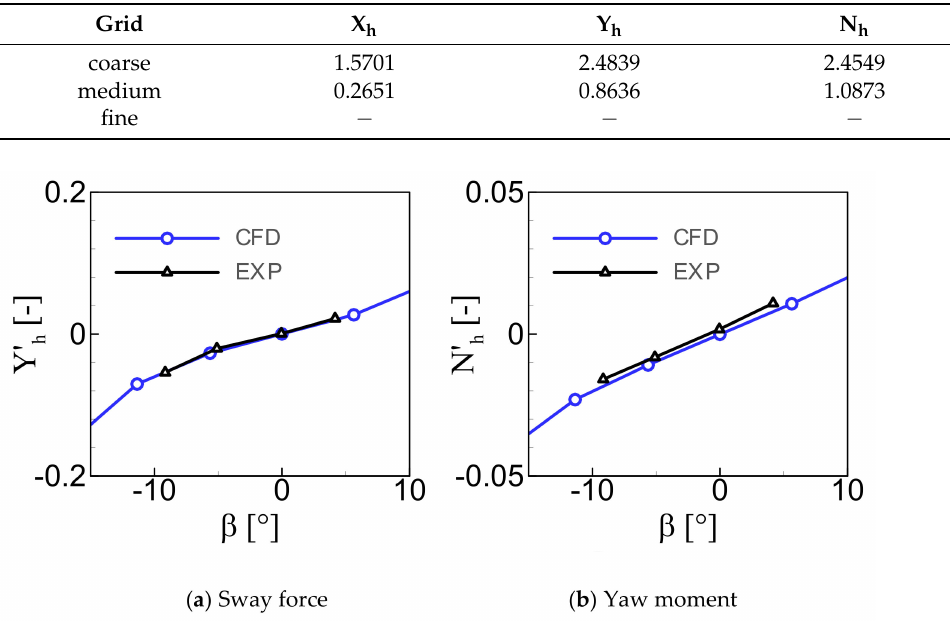
Figure 6. Sway force and yaw moment versus β in calm water.